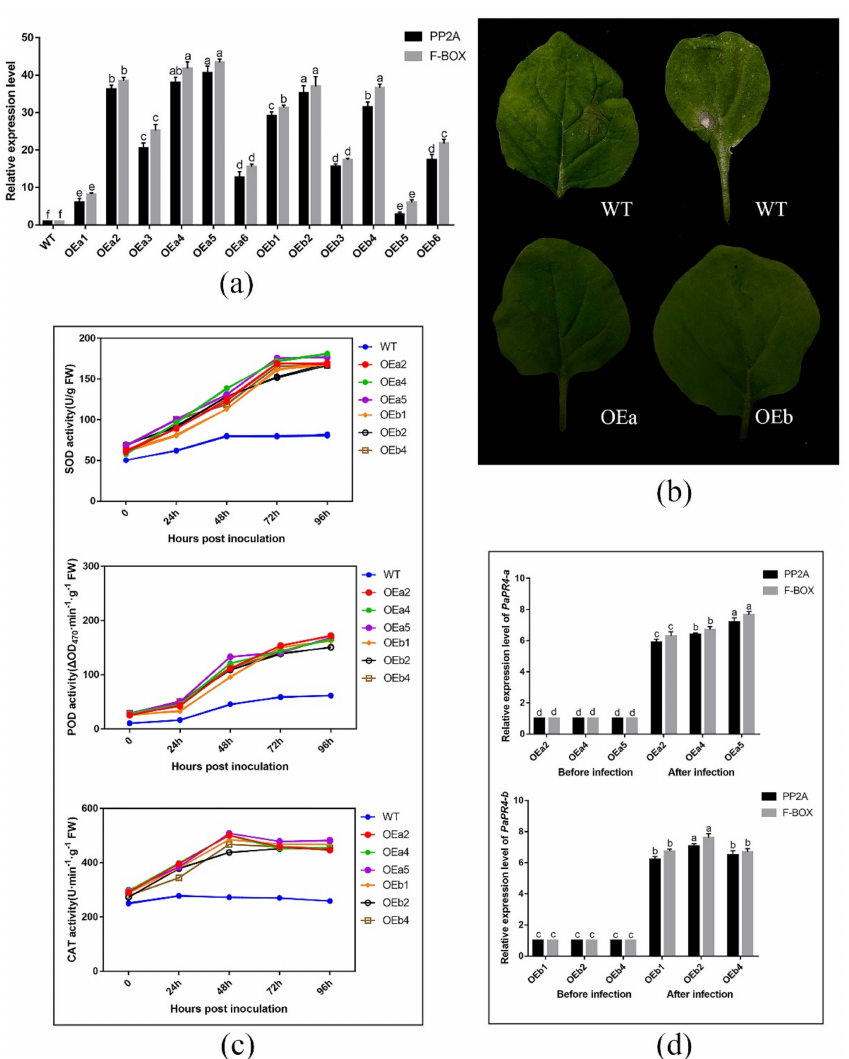
Figure 9. ( a ) RT-qPCR detection of PaPR4-a and PaPR4-b expression in twelve transgenic lines; ( b ) Phenotype of wild-type and transgenic tobacco plants inoculated with Lo. piceae at a week post- inoculation; ( c ) ROS scavenging enzymes activities after inoculation; ( d ) Relative expression levels of PaPR4-a and PaPR4-b after inoculation. WT: wild type; FW: fresh weight. The relative expression levels represent the normalized mean ± standard deviation (SD) ( n = 3 biological replicates). The different letters indicate significant differences between samples determined by the Waller-Duncan test ( p <